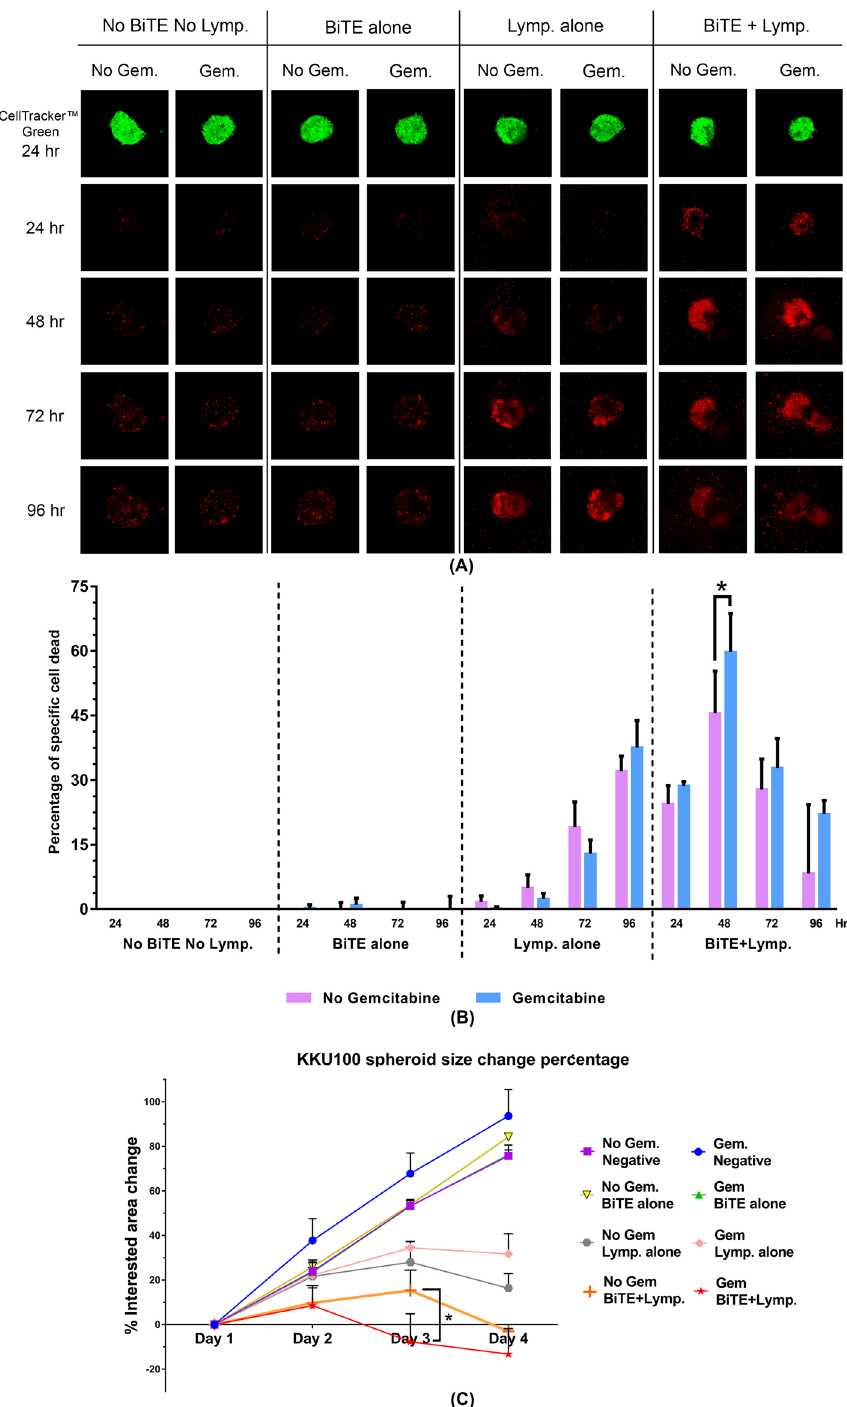
Figure 7. Combination gemcitabine and BiTE enhanced T cell activity to kill CCA spheroid. ( A ) The dead cells in KKU100 spheroid after co-culturing with T cells in presence or absence of gemcitabine and/or BiTE were observed by PI staining (red color) at 24, 48, 72, and 96 h after co-culturing. The living cells staining with CellTracker (green color) were monitored at the first time point to locate the interested area. ( B ) The bar graph showed the percentage of specific cell dead relative to the simultaneously cell dead of non-treatment control (no BiTE treated, no gemcitabine, and no lymphocyte condition). ( C ) The sizes of spheroid were measured and represented as percentage of interested area change relative to non-treatment control at the first of time point. Linear graph showing the spheroid size progression percentage. Data are presented as the mean ± standard error of the mean (SEM) (error bar) (* p <